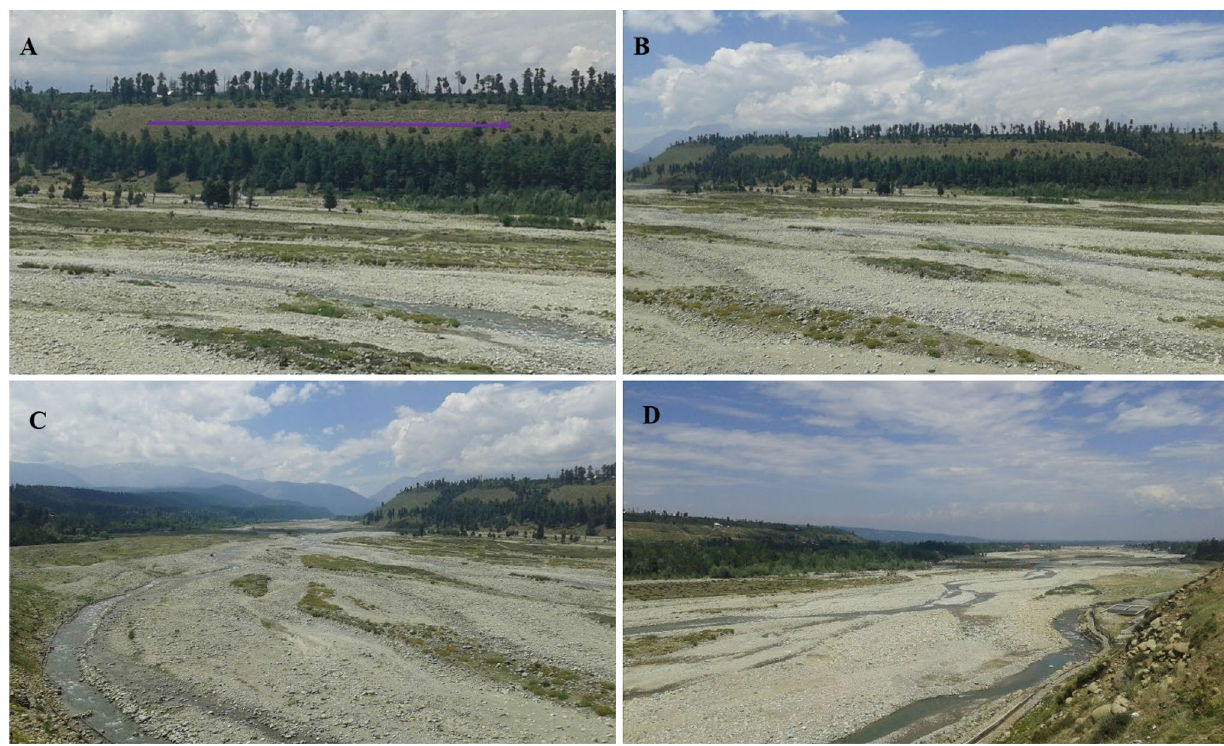
Fig. 3 Field evidences of different geomorphic units in Rambiara river basin. a River Terrace, b alluvial plain and c , d braded river channel, river